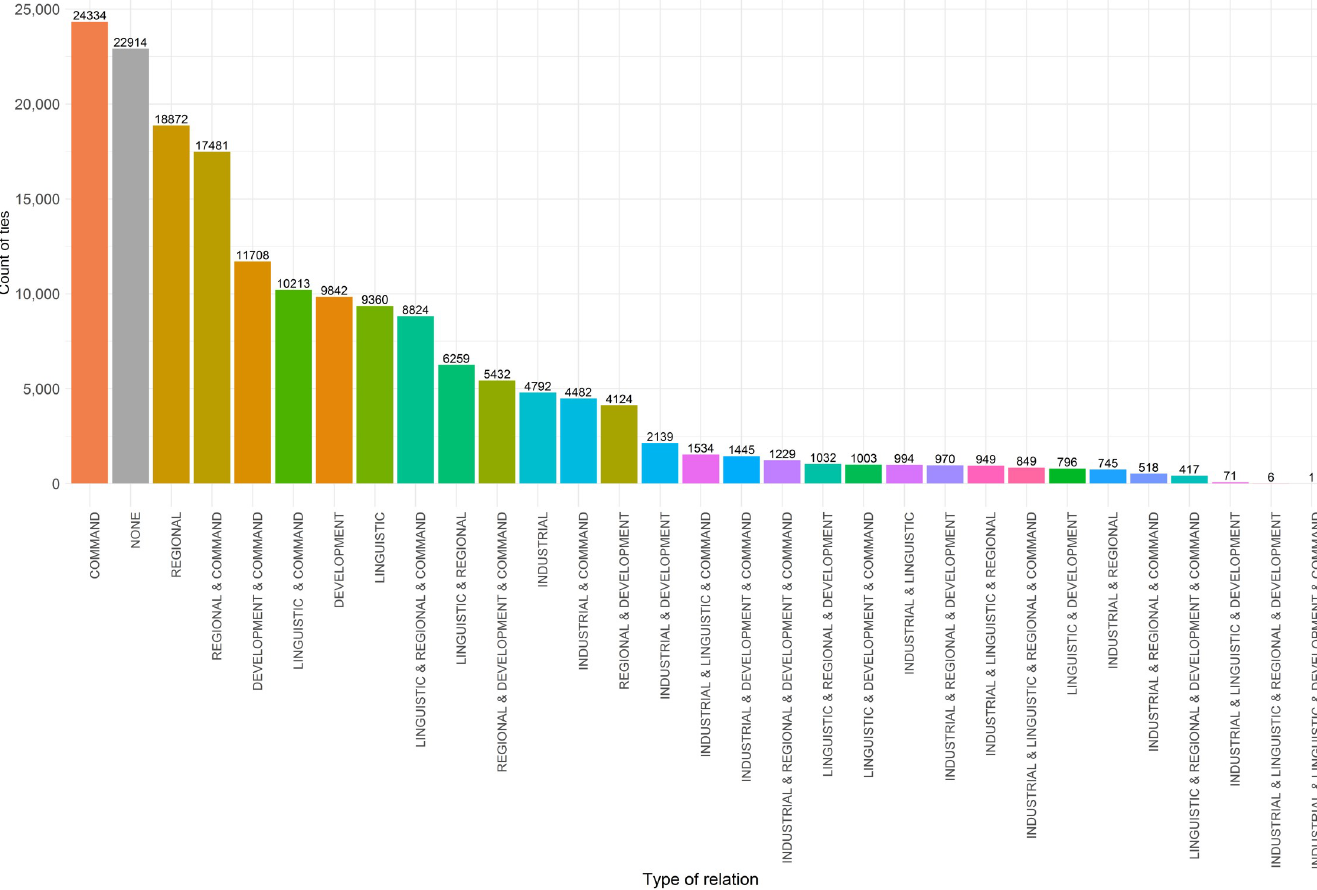
PLOS ONE | https://doi.org/10.1371/journal.pone.0255461 August 17,